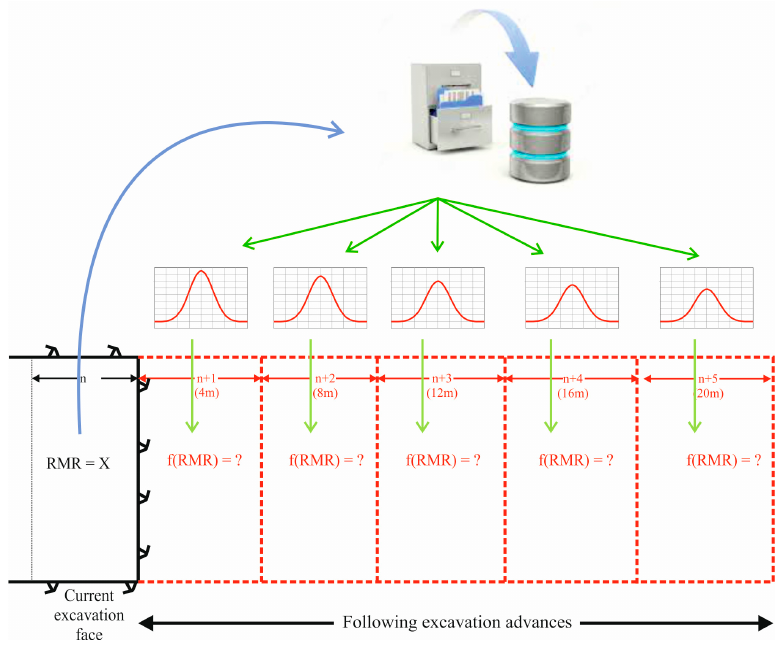
Figure 1. Scheme of the methodology used (adapted from [21]).